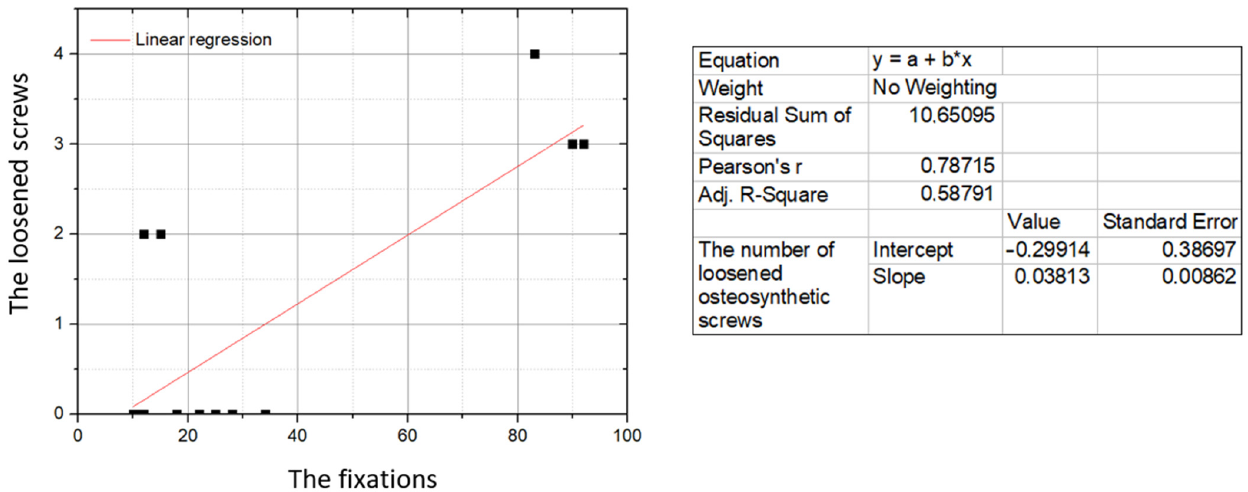
Figure 1. Correlation between the number of loosened osteosynthetic screws (vertical axis) and the number of fixations with 3D mini-plates (horizontal axis). Data for individual studies.